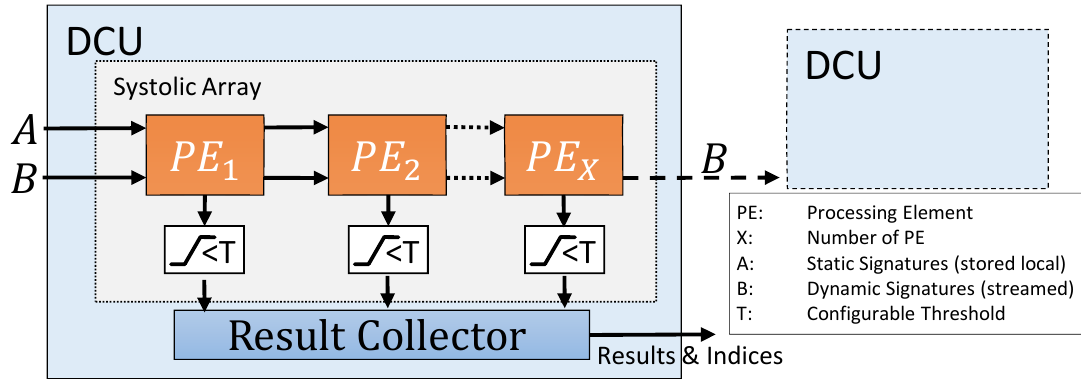
Figure 2. Architecture of the distance comparison